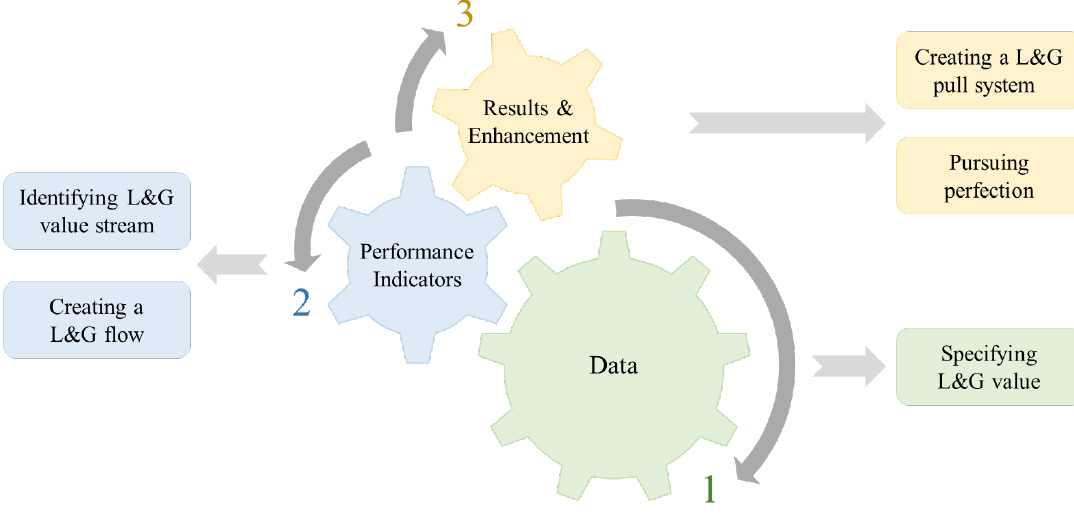
Figure 1. Three drivers and the design principles of